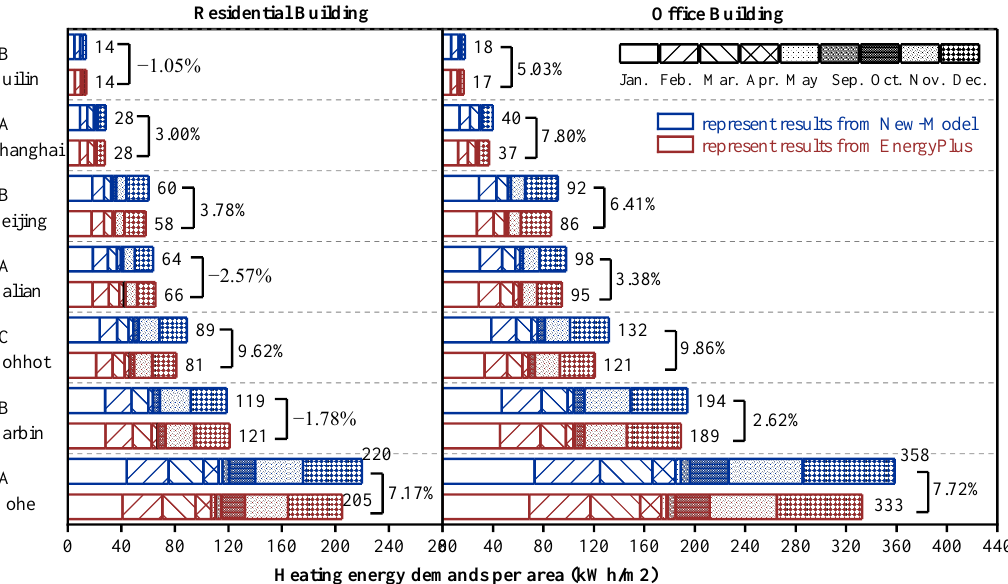
Figure 9. Annual heating loads of residential and office buildings in representative cities in different climate zones.